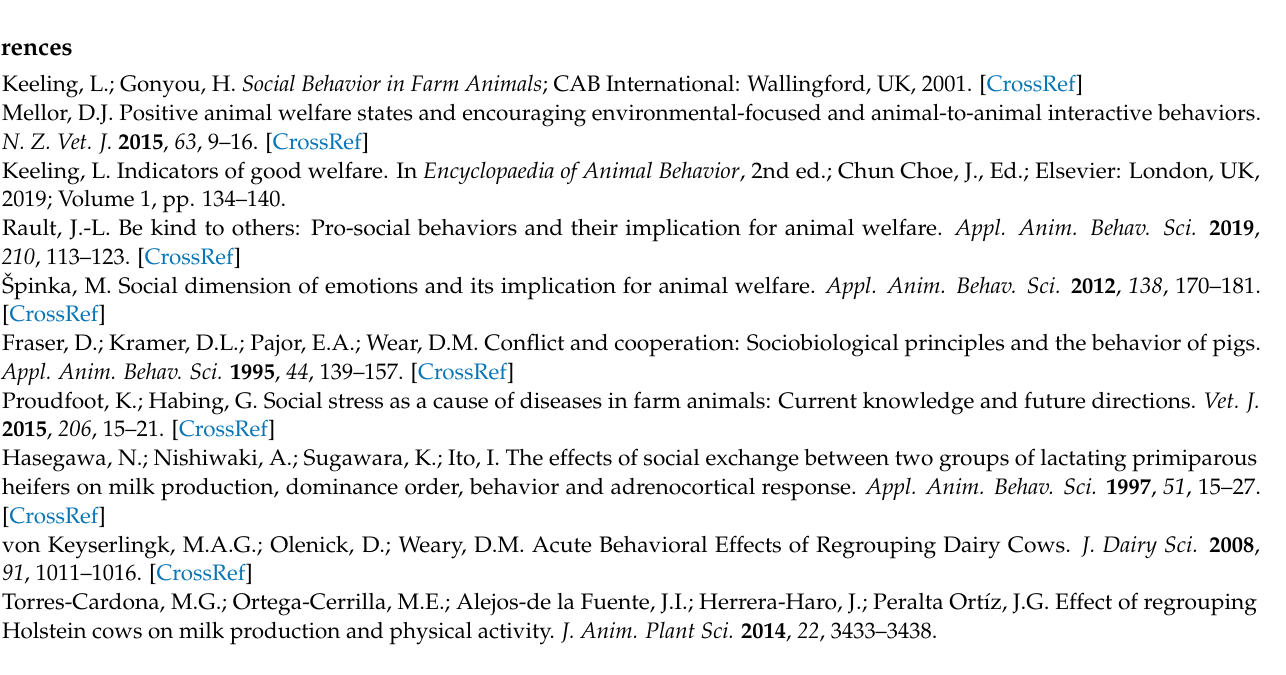
diet; Table S2: Effects of ewe breed on milk yield, composition, oxidative stability, flow rate and kick responses; Table S3: Effects of ewe breed on the average, minimum and maximum heart rate (beats/min), the number of escape attempts and vocalizations per min and the flight distance (m) during the isolation—flight distance